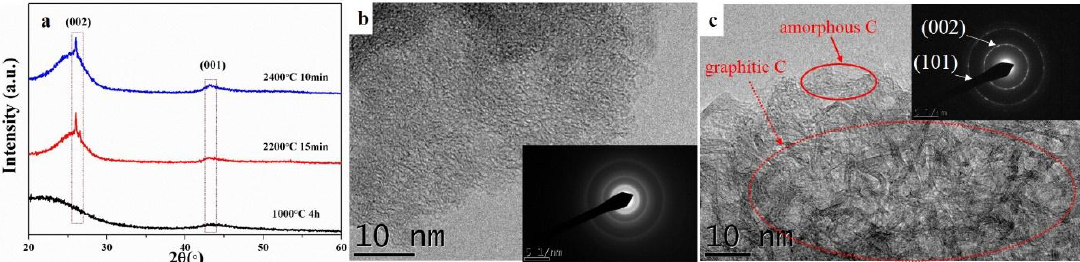
Figure 3. ( a ) XRD patterns of biocarbon structures obtained using different temperatures and dwell times; ( b , c ) are high resolution transmission electron microscope (HRTEM) images of the biocarbon structures prepared at 1000 °C and 2400 °C, respectively. The insets are the corresponding selected area electron diffraction (SAED) patterns.